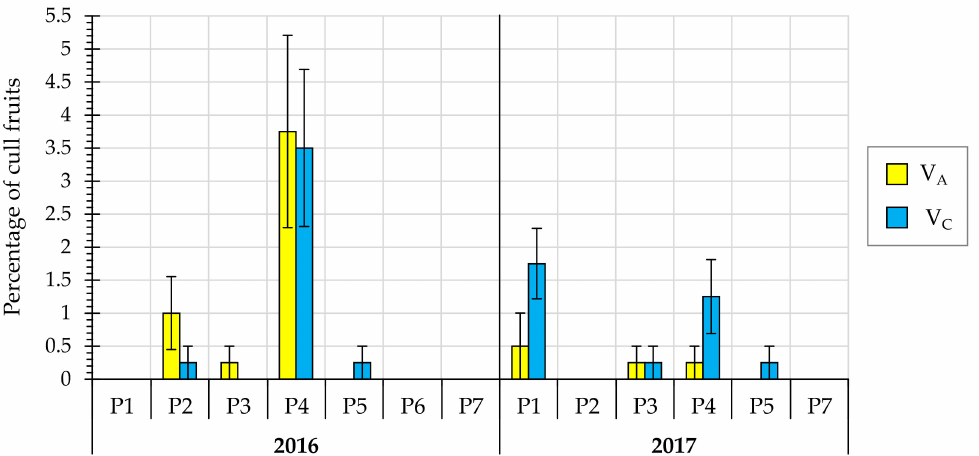
Figure 8. Cull fruit (%) with more than three Aonidiella aurantii scales per fruit (mean value with standard error bar), in function of the treatment (V A : adjusted volume, V C : conventional volume), for each plot (P1–P7) and year (2016 and